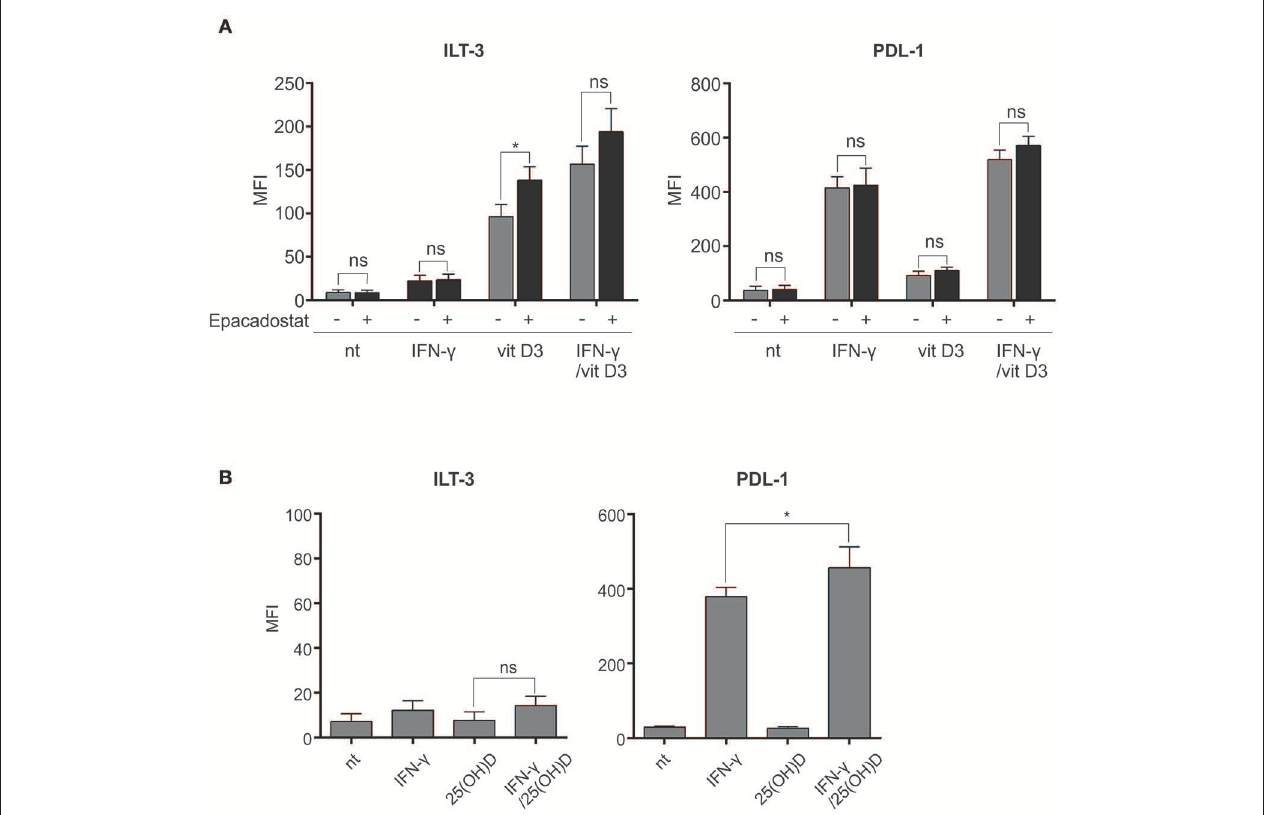
FIGURE 5 | Tolerogenic synergy between IFN- γ and vit D 3 is independent of IDO activity and increased 25(OH)D-to-vit D 3 synthesis. (A) To exclude the enzymatic activity of IDO for the tolerogenic effects of IFN- γ and vit D 3 , we pre-treated the DCs with a highly specific IDO inhibitor Epacadostat for 2h. Afterwards, the DCs were stimulated for 24h and stained for surface expression of ILT-3 and PDL-1, as depicted in the figure. The results are expressed as mean ± SD of MFI from three independent experiments. (B) Dendritic cells were cultured in the presence of IFN- γ and 25(OH)D for 48h, as depicted in the figure. Surface expression of ILT-3 and PDL-1 was evaluated after 48h. Shown is mean ± SD of four independent experiments. Statistical analysis was made comparing individual pairs and using Student’s unpaired t -test (ns, non-significant; * p <